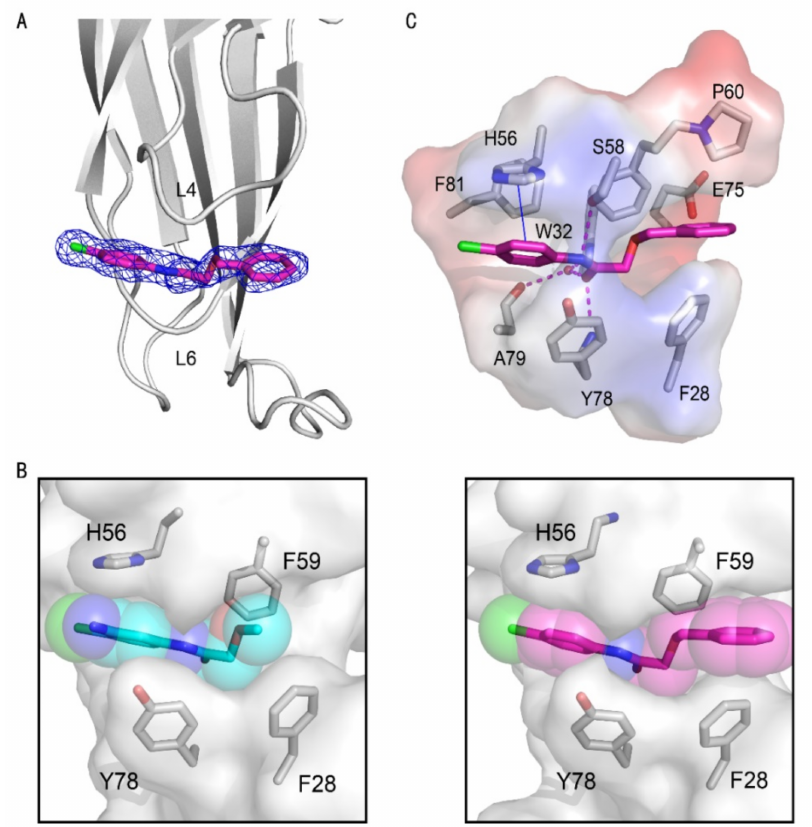
Figure 3. Crystal structures of the AF9 YEATS domain in complex with compound 10 . ( A ) Cartoon representation of the AF9 YEATS domain in complex with compound 10 (carbon atom in pink), whose 2Fo–Fc electron density map was contoured at 1 σ (navy mesh). ( B ) Comparison of cavity encapsulation of compounds 2 and 10 that were shown as spheres. ( C ) Detailed interactions be- tween compound 10 and AF9 YEATS with hydrogen bonds (pink dashed line) and π - π interaction interactions are highlighted (blue solid